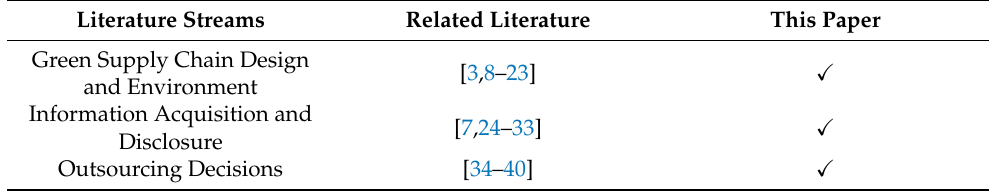
Table 1. Classification of recent